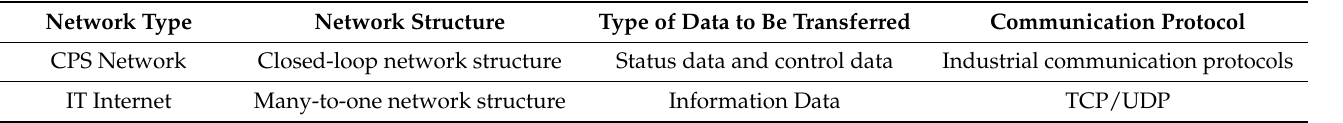
Table 1. Comparison of CPS network and traditional IT network.